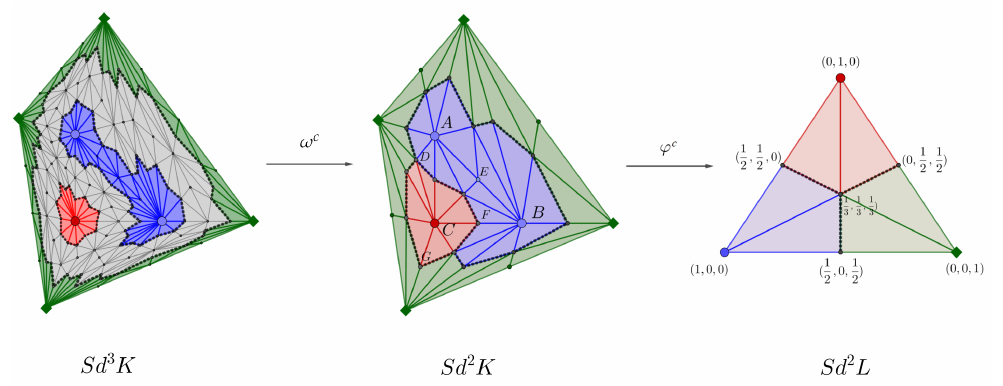
Figure 4. Let K = D ( D P ∪ V P ) be the Delaunay complex of D P ∪ V P where D P is the set { A , B , C } of red and blue points, and V P are the green vertices (depicted in the center). Let L be the simplicial complex with one maximal simplex σ = { v 0 = ( 0,0,1 ) , v 1 = ( 0,1,0 ) , v 2 = ( 1,0,0 ) } (pictured on the right). Let us consider the vertex map ϕ ( 0 ) that sends the blue points A , B to v 1 , the red point C to v 2 , and the green points (labelled as unknown ) to v 0 . Then, ϕ ( 0 ) gives rise to the simplicial map ϕ c and the simplicial-map neural network N ϕ . The decision boundary of N ϕ is pictured on the center as the set of points in the boundary of the red, blue or green region. For example, N ϕ ( D ) = ( 1 N ϕ ( F ) = ( 1 ) . Let us consider now the barycenter subdivision of K , 1 ,0 ) and N ϕ ( G ) = ( 0, 1 , 1 2 2 2 2 shown on the left and the simplicial map ω c which relates both simplicial complexes. The decision boundary of N ϕ ◦ ω is the gray zone on the left